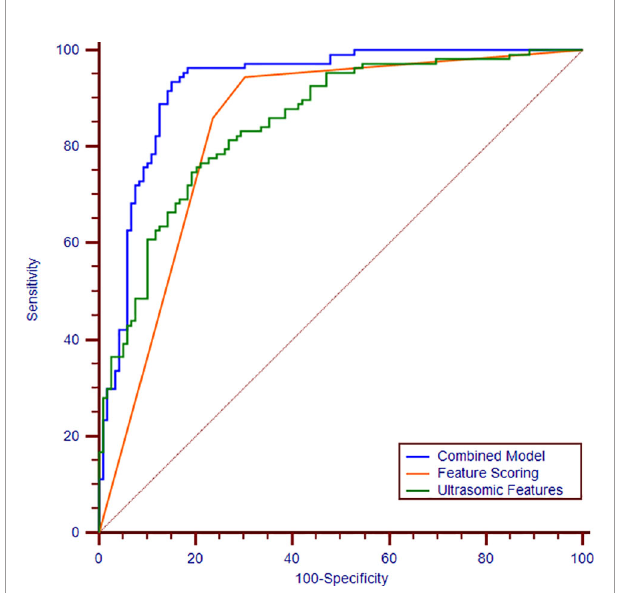
FIGURE 3 | Receiver operating characteristic curves of the combination of ultrasomics features and radiologist ’ s score (blue curve), ultrasomics features (green curve), and radiologist ’ s score (orange curve). The areas under the curves are 0.93, 0.86, 0.84, respectively.